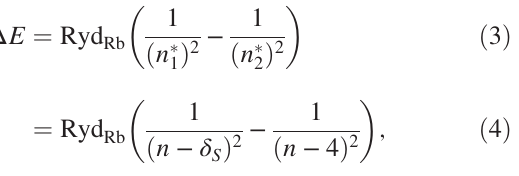
Fig. 1. Since the neutral atoms start in an interacting frame, the usual concepts of scattering theory are not well defined in this case as there are no asymptotic initial states.